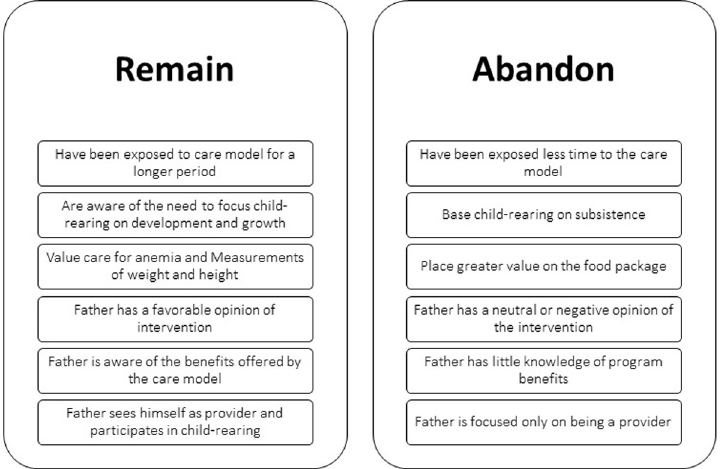
Fig 5. Individual profiles concerning participation in ECD program. Source: Elaborated by the authors according to the findings of the study.